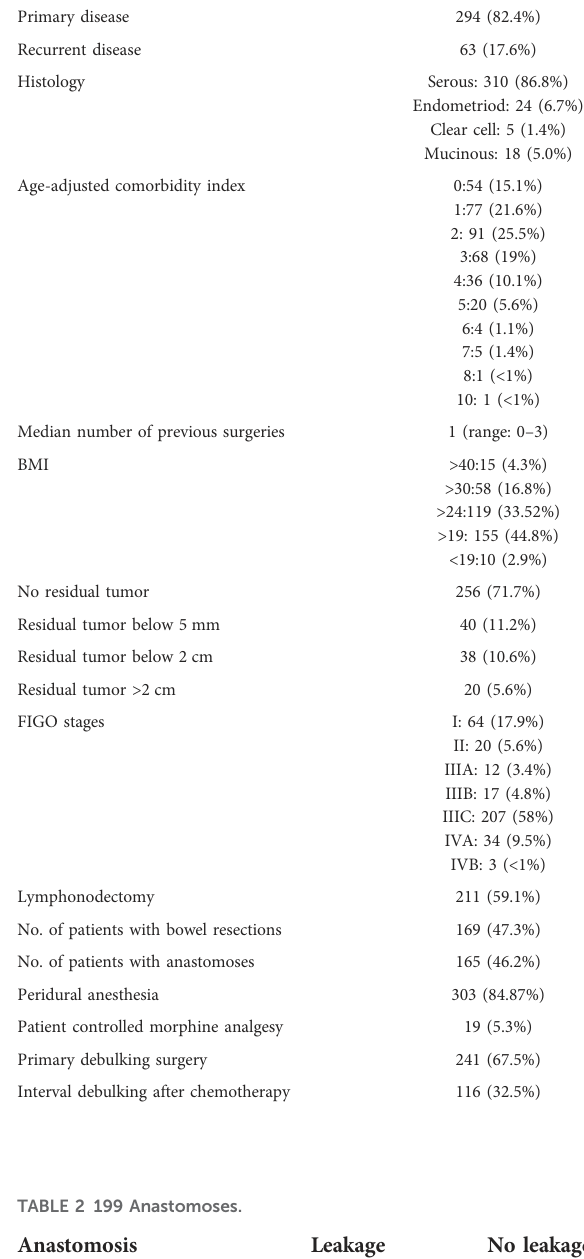
TABLE 1 General patients ’